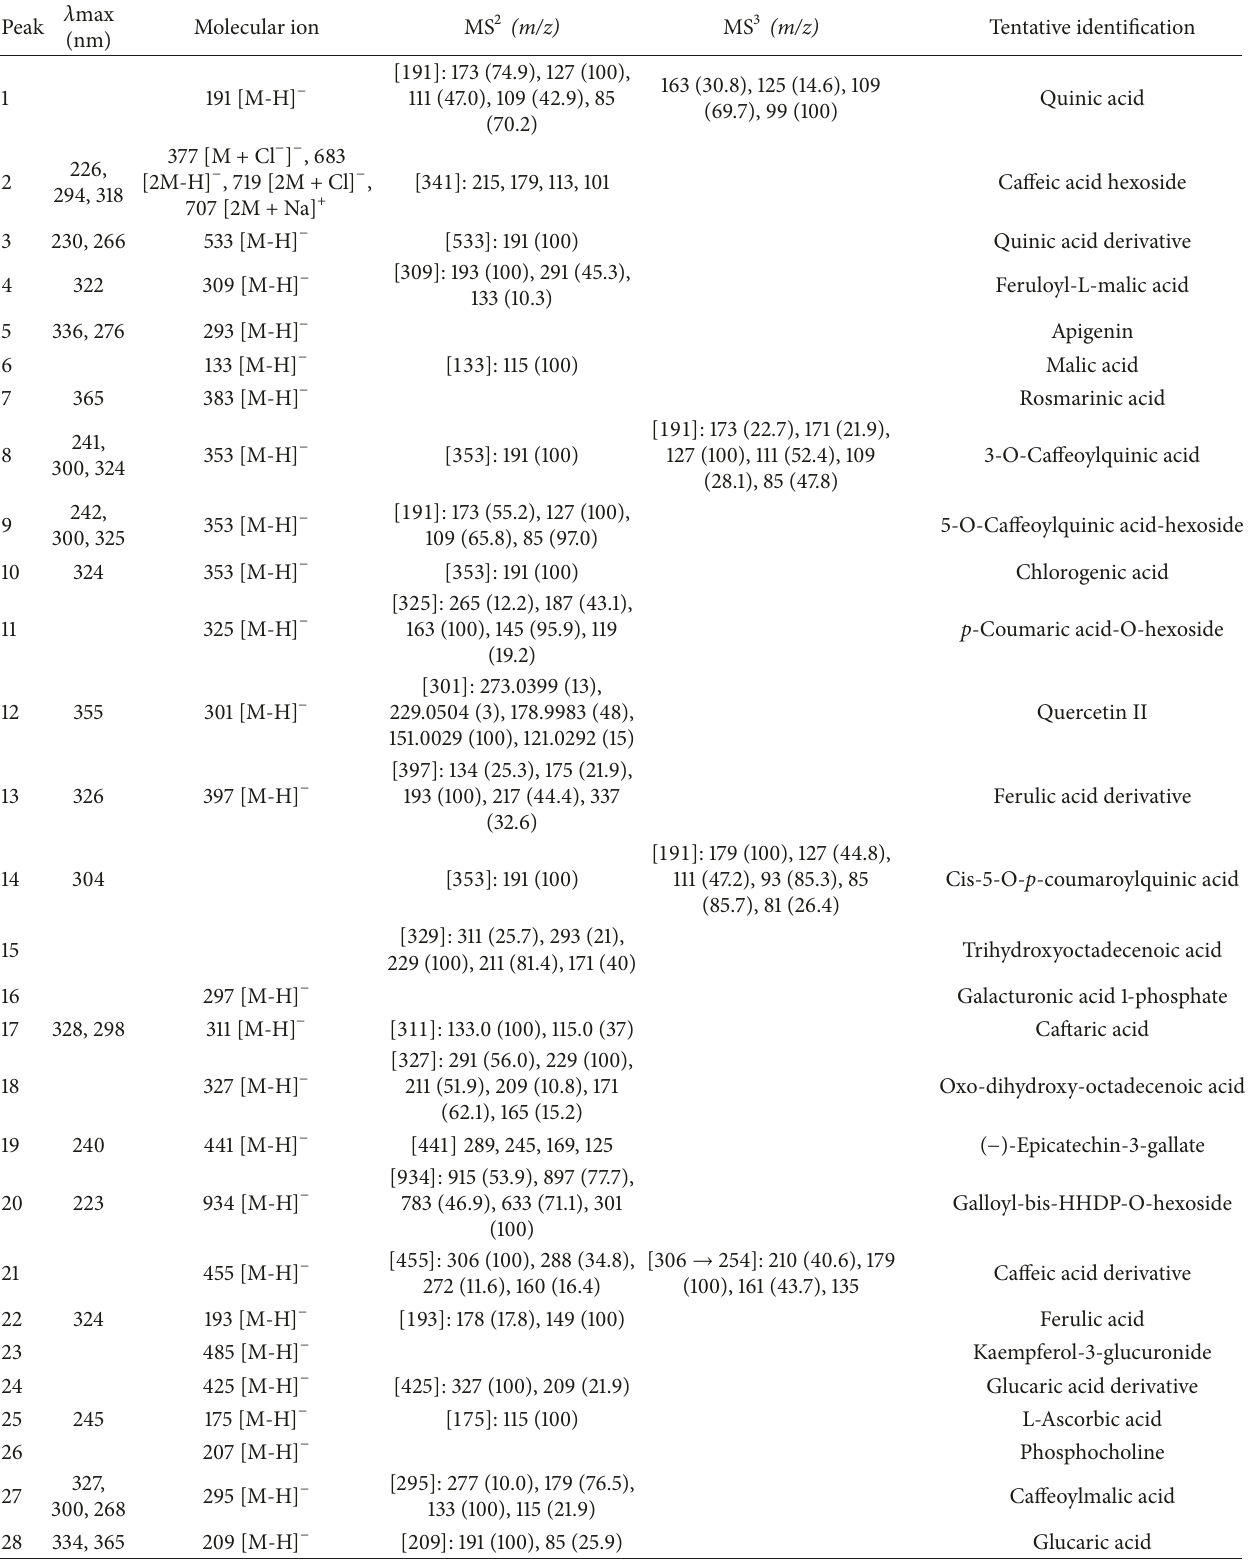
Table 1: The results of chemical analysis of the cambium from Abies nephrolepis